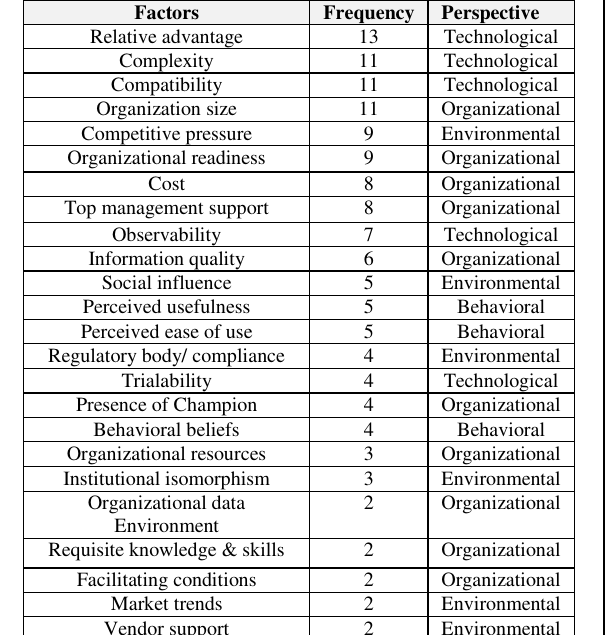
Table 7: Most frequently utilized factors for the adoption of BI